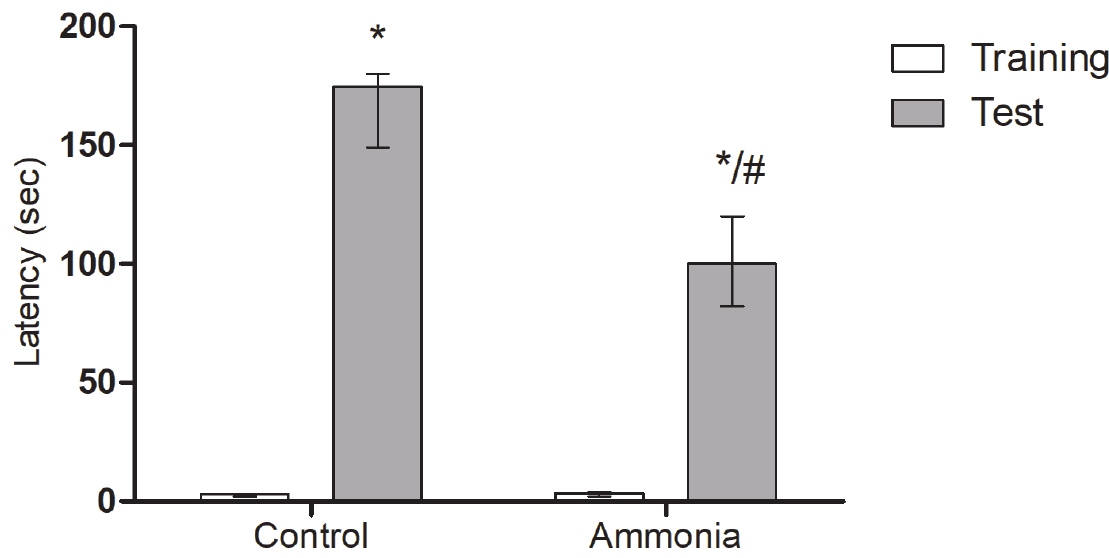
Figure 3. Long-term inhibitory avoidance performance pups after gestational ammonia exposure. Pregnant rats were daily treated with a single injection of ammonium acetate (2.5mmol/Kg) or saline during all gestational period. Thirty days after delivery animals were subjected to the step-down inhibitory avoidance task. Data are presented as median and interquartile ranges, (n=15, each/group). *Different from training section in the same group ( P <0.05, Wilcoxon test). #Different from test section compared to control group ( P <0.05, Mann-Whitney